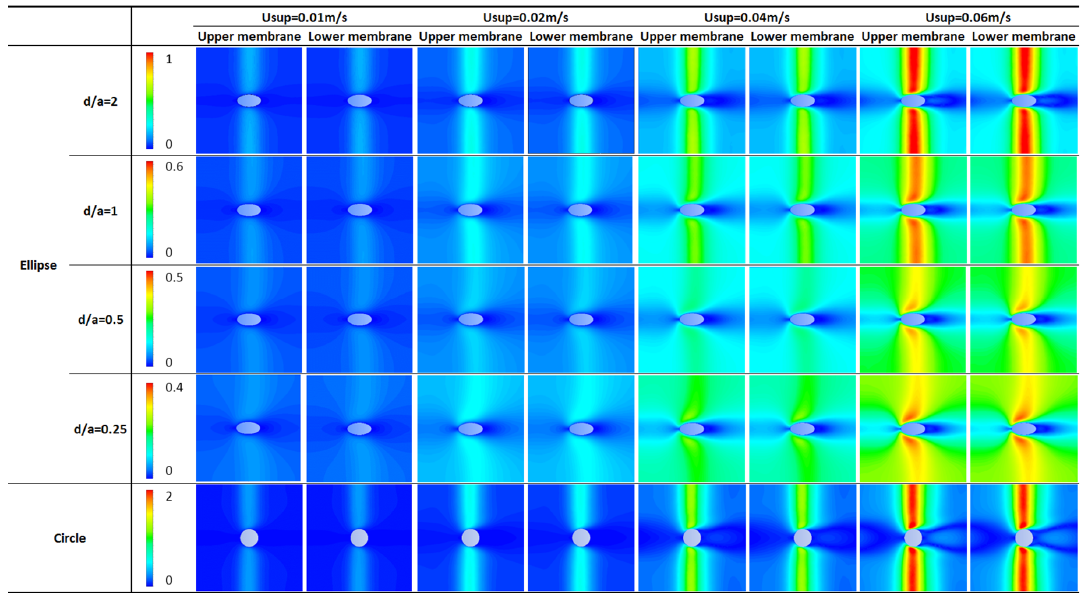
Figure 12. The contour plots of the wall shear stress ( τ ) profile on the upper membrane and the lower membrane generated by the pillar-like feed spacer. Math. Comput. Appl. 2018 , 23 , 80 13 of 16